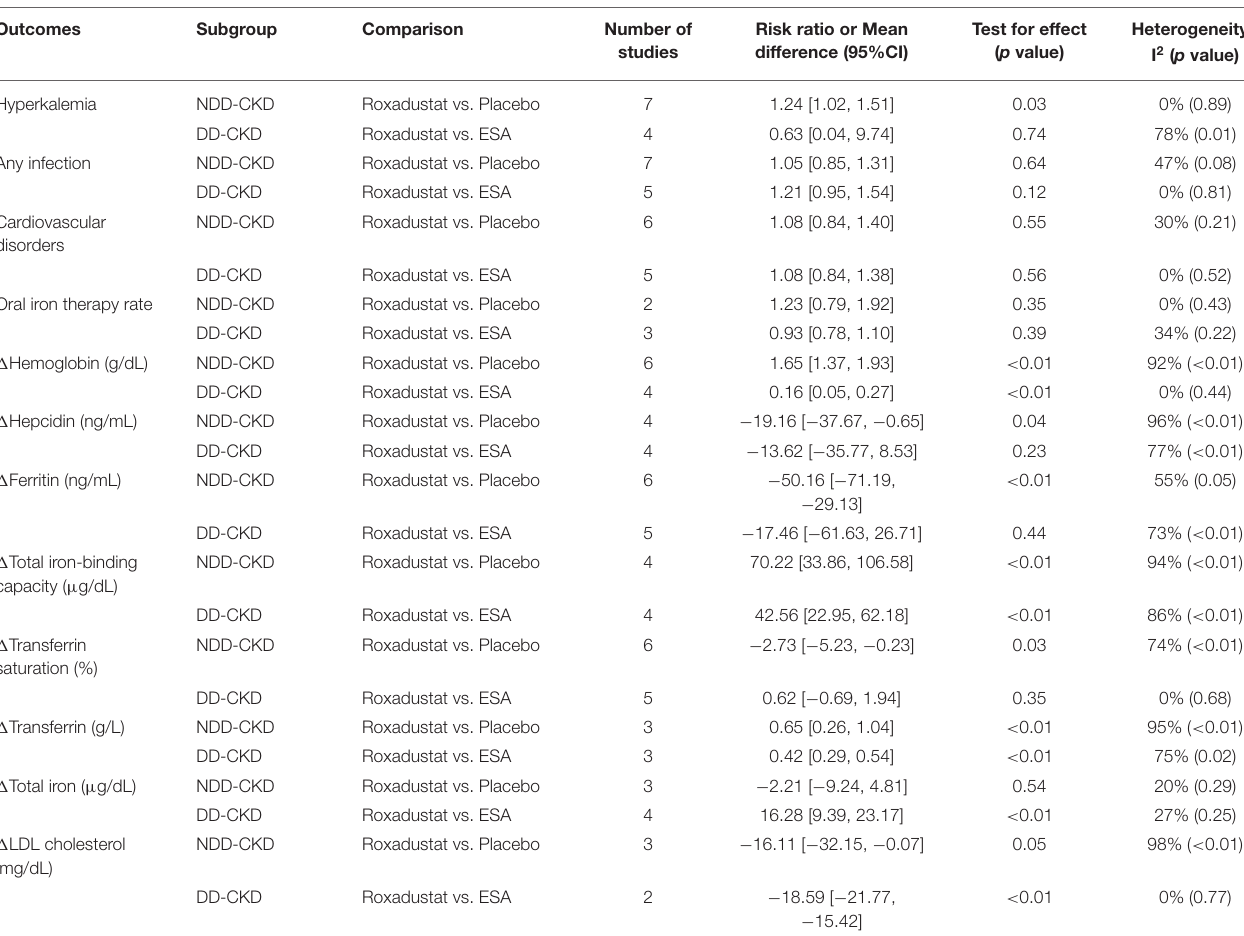
TABLE 2 | Other outcomes.